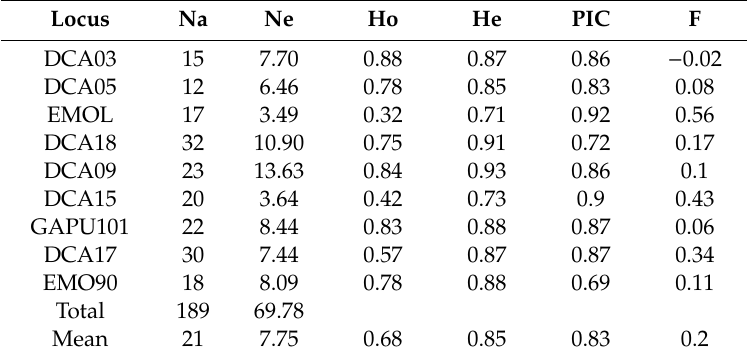
Table 1. The diversity indices of 9 simple sequence repeat (SSR) markers detected in 218 olive accessions collected in Algeria, Tunisia, Syria and